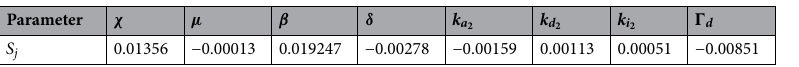
Table 3. Sensitive index of the parameters used in the model.